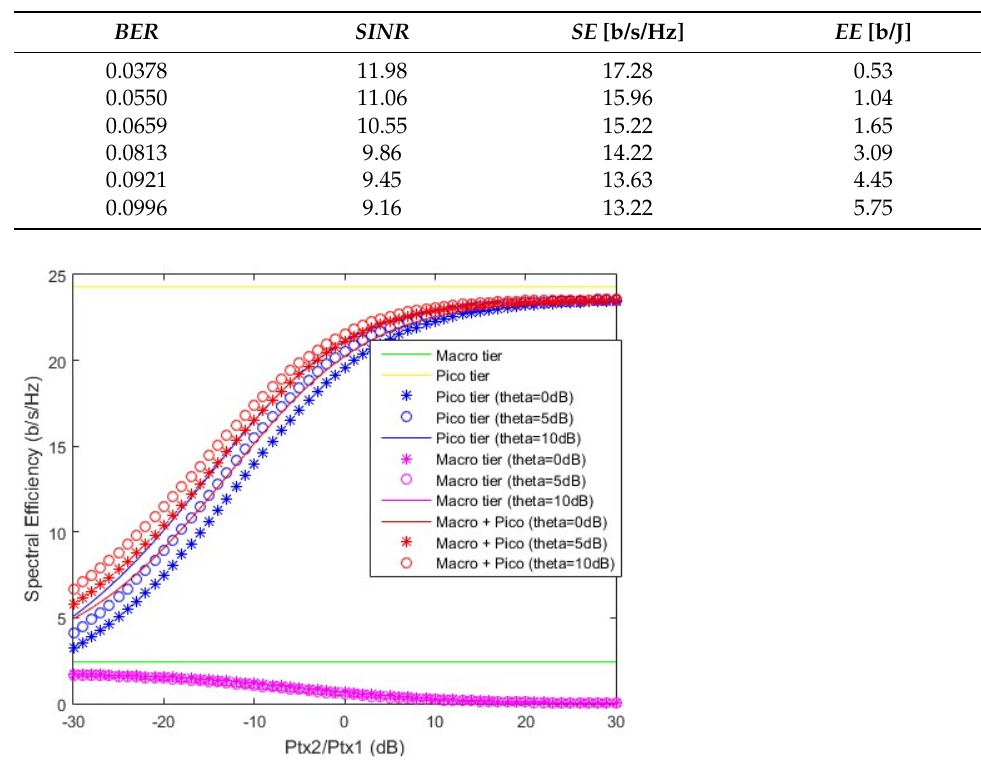
Figure 6. Spectral efficiency vs. relative transmitted power and cell range expansion bias (theta).